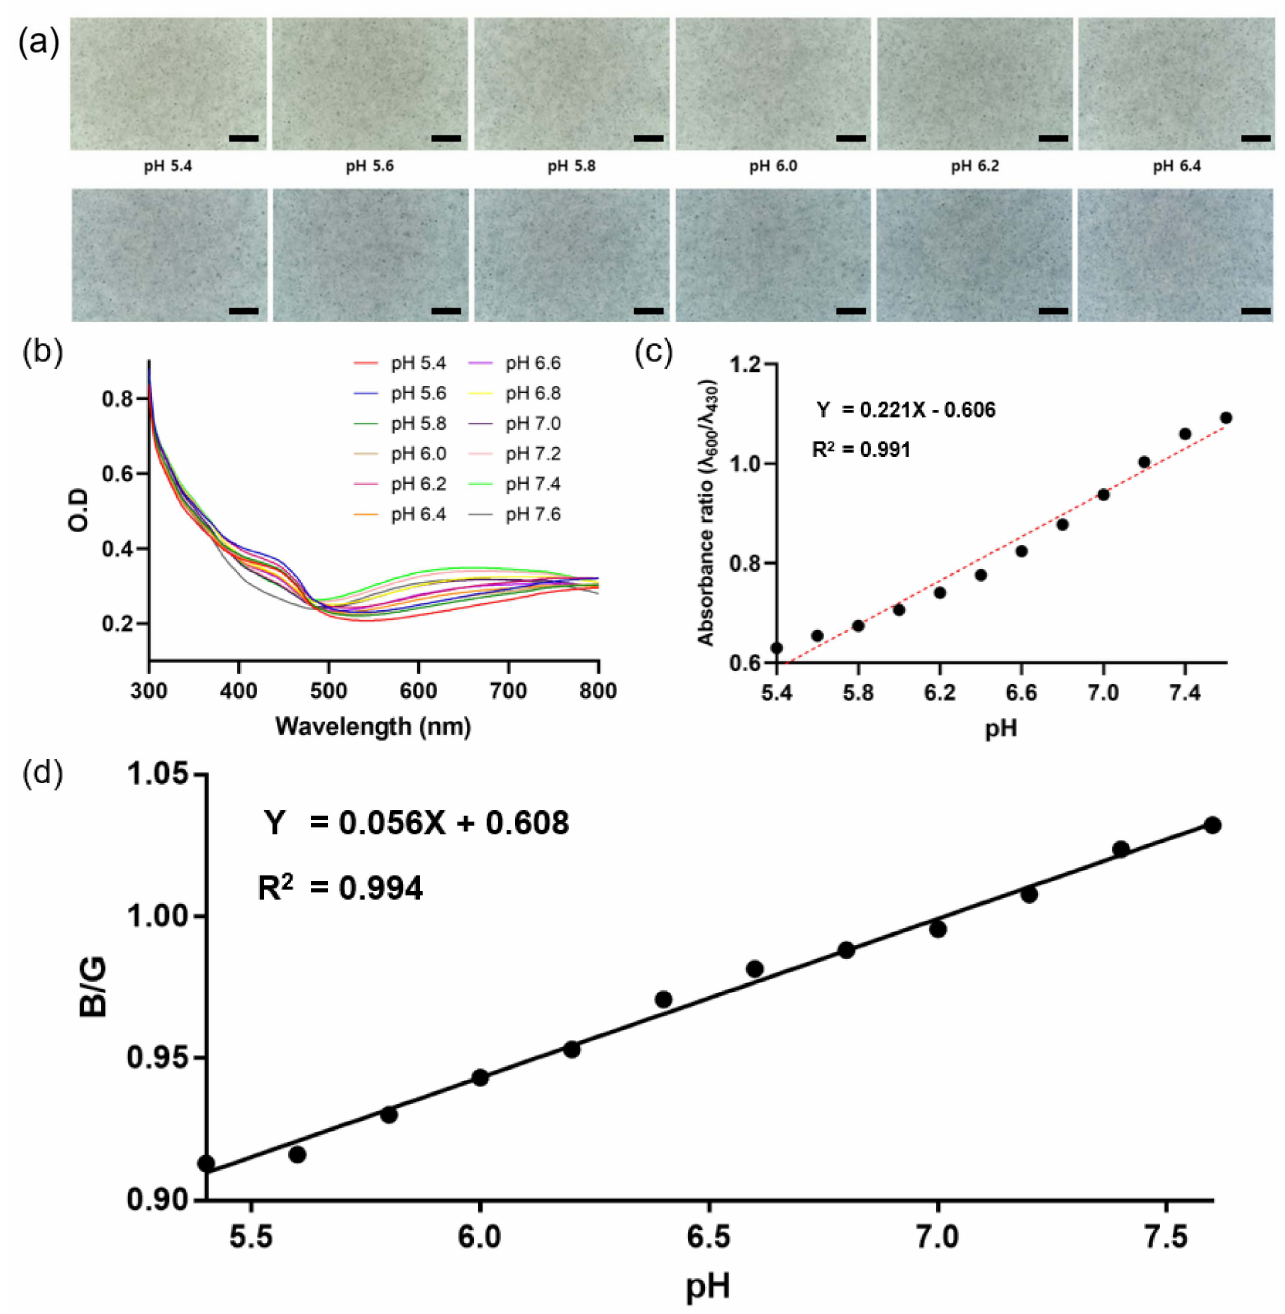
Figure 6. Colorimetric response of PNHC with the surrounding pH. ( a ) Microscopic images of the PNHC surface exposed to various pH conditions (from 5.4 to 7.6). Scale bar represents 200 µ m. ( b ) Absorbance spectra of the PNHCs at specific wavelengths changed by pH. ( c ) Absorbance ratio ( λ 600 / λ 430 ) of the PNHC with pH conditions. ( d ) B/G intensity ratio of PNHC vs. pH. The relative signal intensity (B/G) is a ratio of the blue value divided by the green value, which is quantified using ImageJ